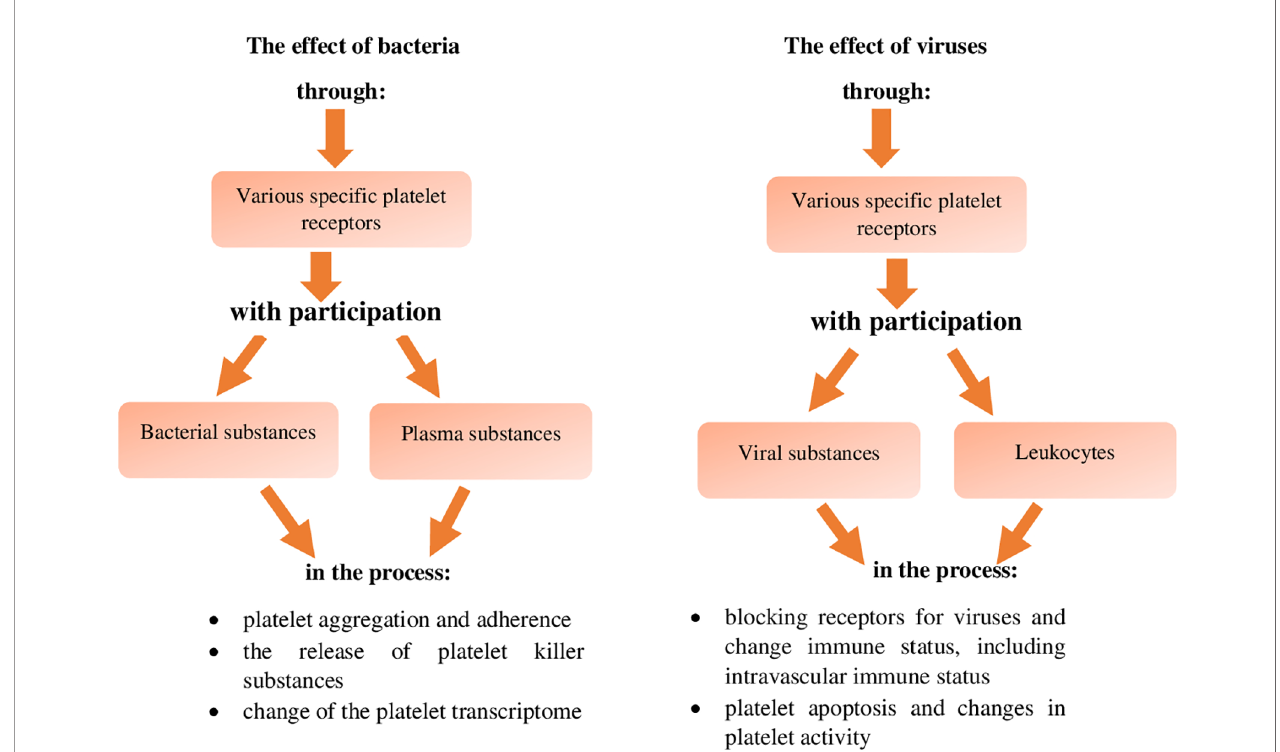
FIGURE 2 | The effect of bacteria and viruses themselves on platelets leading to the inactivation of these pathogens (references in the